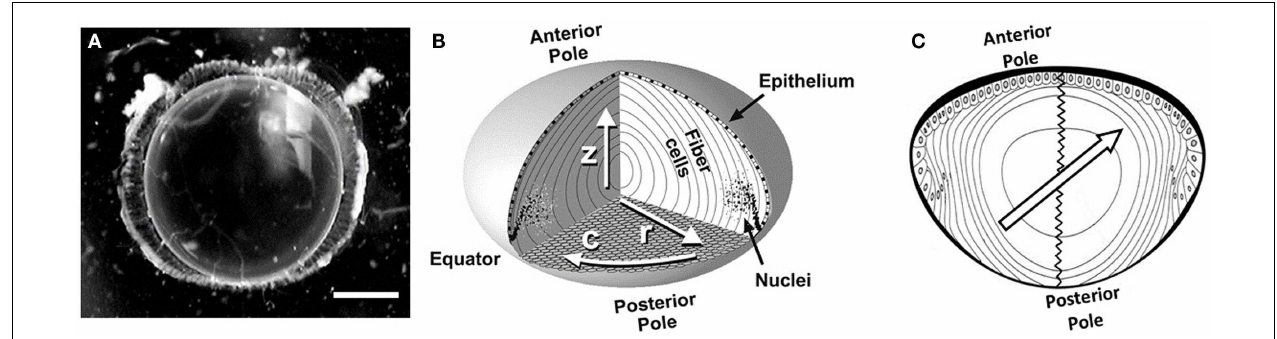
Jacobs et al. (2004). (C) The 2D schematic of the lens axial cut with the anterior and posterior poles marked and the zigzag sutures connecting the poles illustrated.The center-located arrow demonstrates the direction of the applied excitation gradient, which is in parallel with the cortical fiber cell directions in upper-left and lower-right regions. At the same time it is perpendicular to the fiber cell extrusion direction in the upper right and lower left